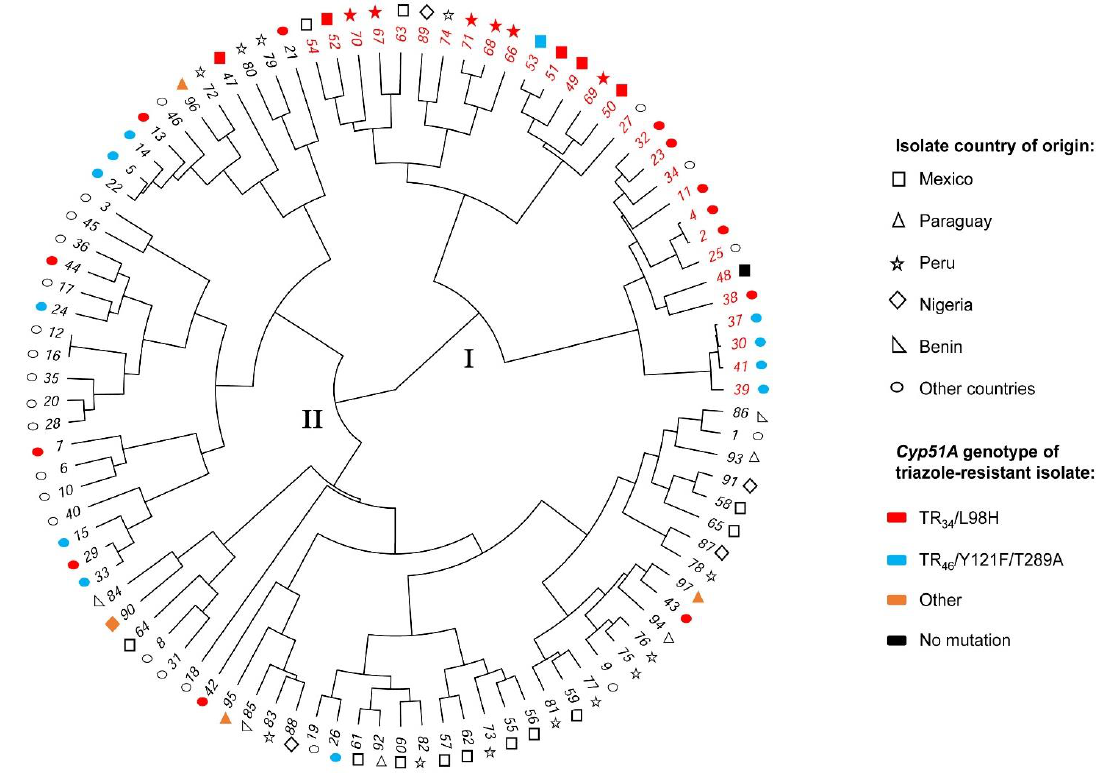
Figure 1. Circular phylogenetic tree depicting the relationship among triazole-resistant and susceptible Aspergillus fumigatus isolates. Genetic relationship between triazole-resistant isolates and selected susceptible Aspergillus fumigatus isolates from this study and selected publicly available triazole-resistant and susceptible worldwide isolates (short tandem repeat; Euclidian dissimilarity and Ward’s method for row agglomeration). Isolates were clustered into two clades: clade-I (red sample ID number) and clade-II (black sample ID number). Figures represent isolates country of origin. Color inside figures represent the cyp51A gene sequencing result (mutations) of triazole-resistant isolates. Abbreviations: ID = identification.